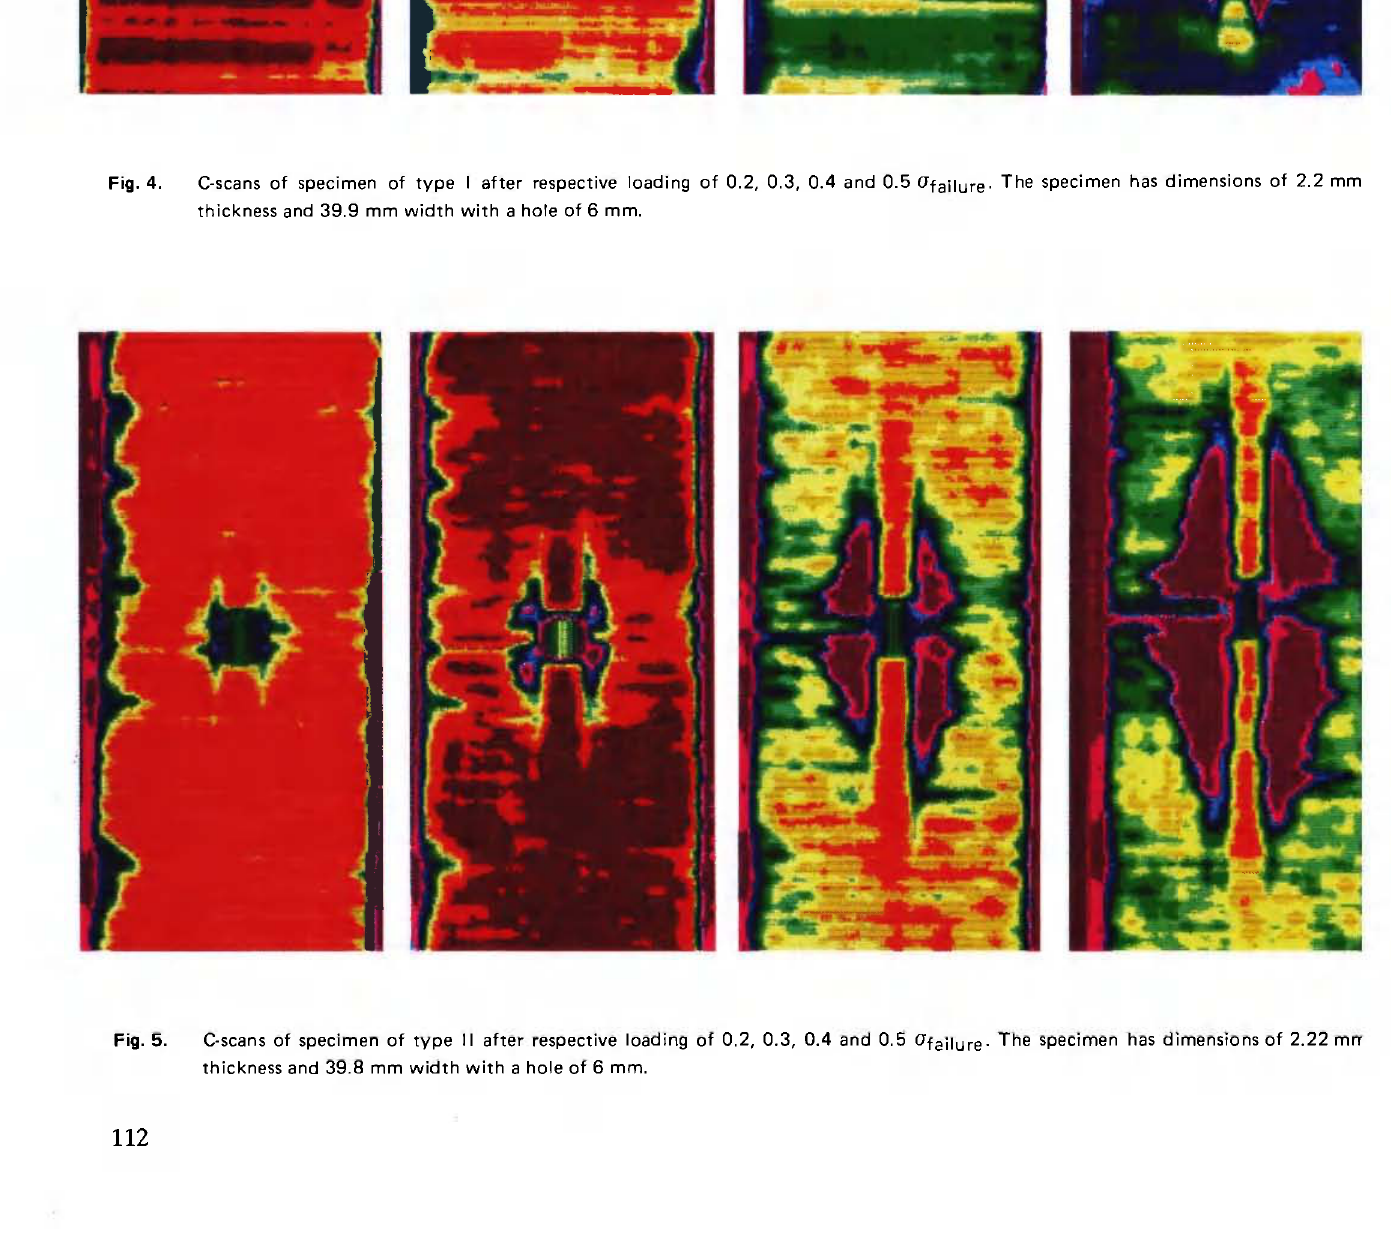
Fig. 5. C-scans of specimen of type II after respective loading of 0.2, 0.3, 0.4 and 0.5 ^failure- The specimen has dimensions of 2.22 mrr thickness and 39.8 mm width with a hole of 6